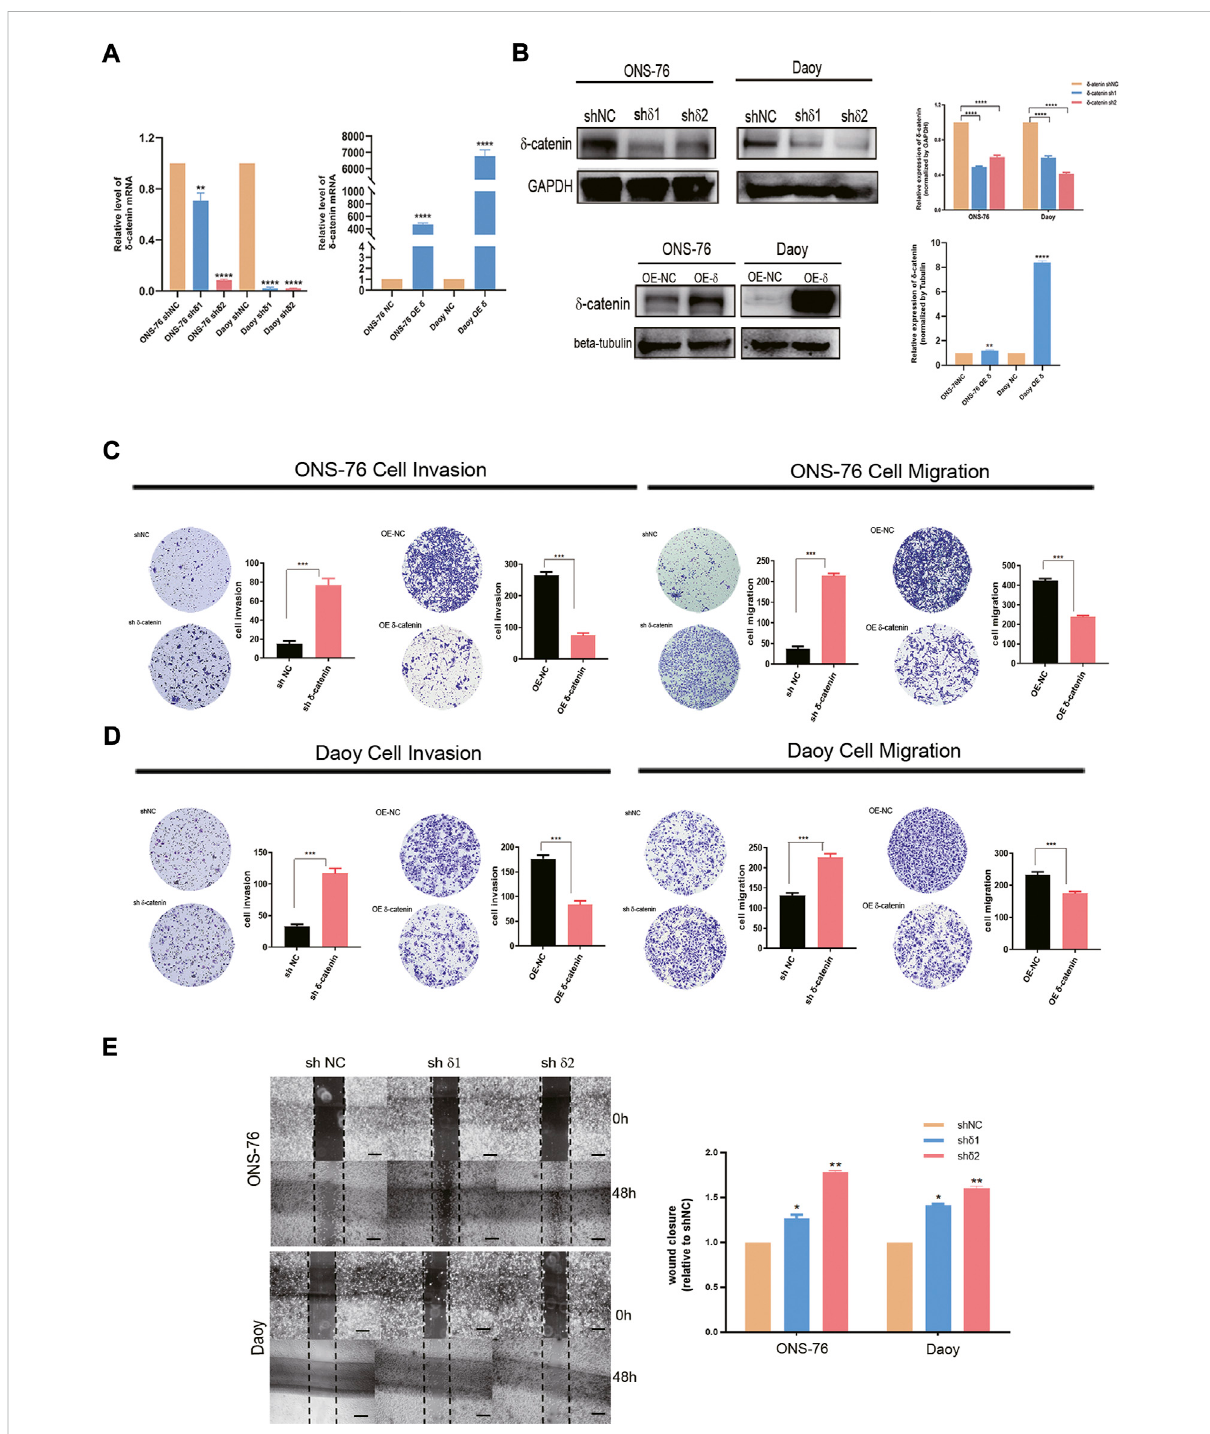
FIGURE 4 Effects of delta-catenin knockdown and overexpression in Daoy and ONS-76 cells migration and invasion. (A) Real-time quantitative PCR analysis of delta-catenin mRNA following lentiviral transfection. β -actin was used as a control. (B) Western blot analysis of delta-catenin expression following lentiviral transfection. GAPDH and Tubulin were used as controls. (C) Representativeimages (×10 magni fi cation)of invasion and migration bydelta-catenin-knockdownandoverexpressingONS-76cells. (D) Representativeimages(×10magni fi cation)showinginvasionandmigration bydelta-catenin-knockdownandoverexpressingDaoycells. (E) Cellularmigrationinboththesh#1andsh#2groupsofONS-76andDaoycellswere promoted, as determined via a wound-healing assay. Scale bars, 100 μ